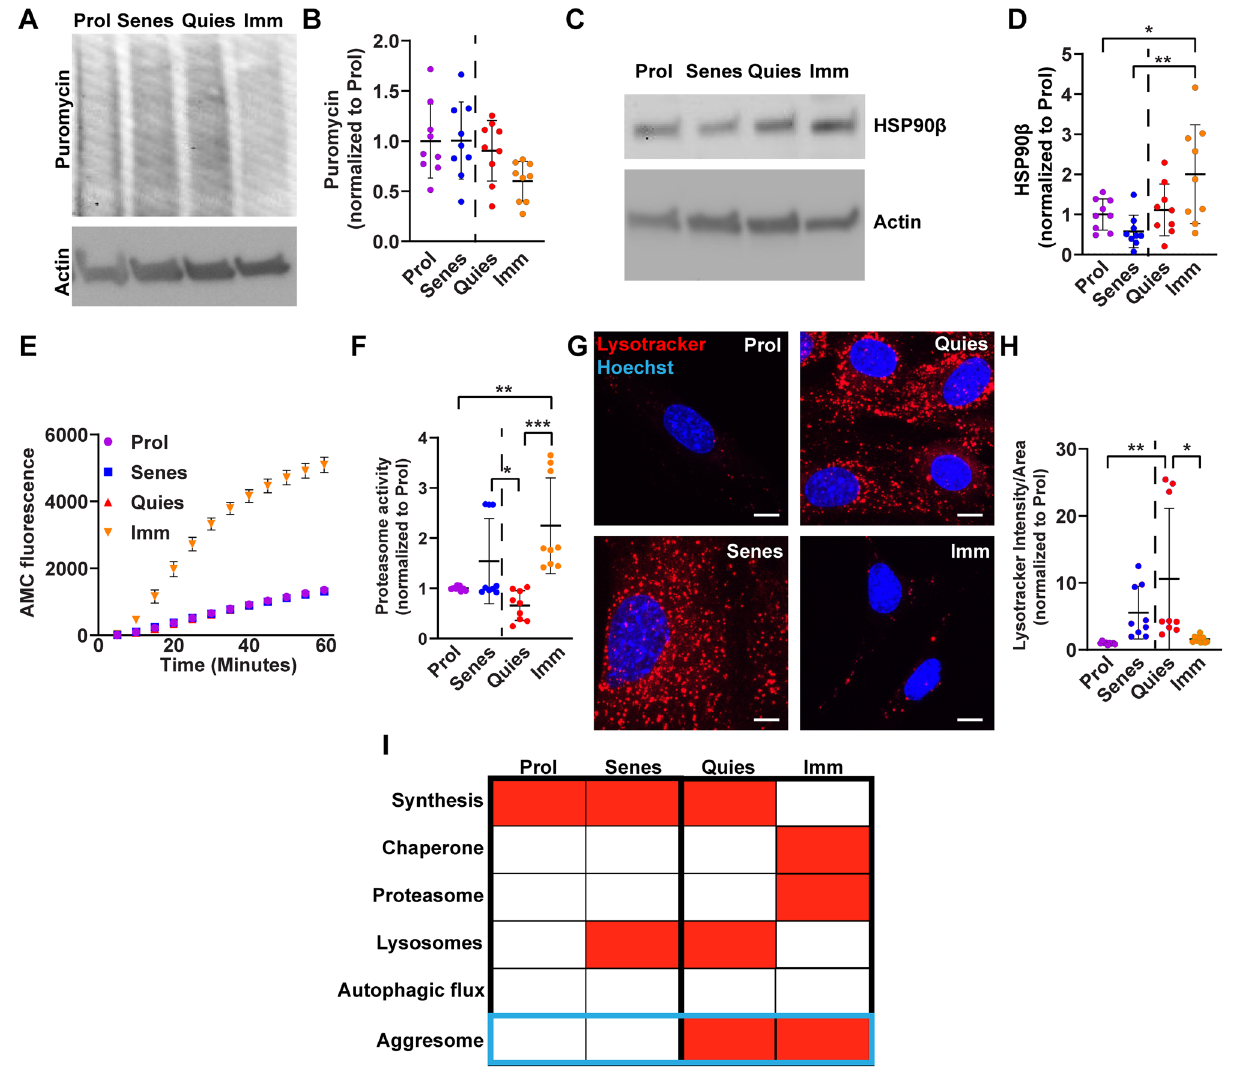
Figure 2. Aggresomes are used within diverse proteostasis networks. ( A , B ) Proliferating, senescent, quiescent, and immortalized fibroblasts were pulsed with 10 µg/mL puromycin for 10 min prior to soluble protein extraction and analysis by western blot. Relative levels of puromycin incorporation and actin expression were visualized by western blot. Samples were analyzed for puromycin levels relative to actin. (N = 3; two-way ANOVA with post-hoc Tukey’s test; mean ± SD). ( C , D ) Proliferating, senescent, quiescent, and immortalized fibroblasts were analyzed for soluble protein expression of HSP90β and actin by western blot (N = 3; two-way ANOVA with post-hoc Tukey’s test; mean ± SD). ( E , F ) Proliferating, senescent, quiescent, and immortalized fibroblast protein lysates were prepared and analyzed for relative levels of trypsin-like proteasome activity by measuring AMC fluorescence as a function of time (N = 3; Two-way ANOVA with post-hoc Tukey’s test; mean ± SD). ( F ) Normalized AMC accumulation at 60 min for each sample. ( G , H ) Proliferating, senescent, quiescent, and immortalized fibroblasts were stained and analyzed for lysosome content (Lysotracker; red) and nuclei (Hoechst; blue) (N = 3; two-way ANOVA with post-hoc Tukey’s test; mean ± SD). The dotted line in each panel separates cell-states that either do or do not form the aggresome. ( I ) Schematic summarizing the proteostasis network experiments in each fibroblast cell-state. Red indicates higher levels of each node of the proteostasis network respectively. Scale bars 10 µm. *p < 0.05, **p < 0.01, ***p <